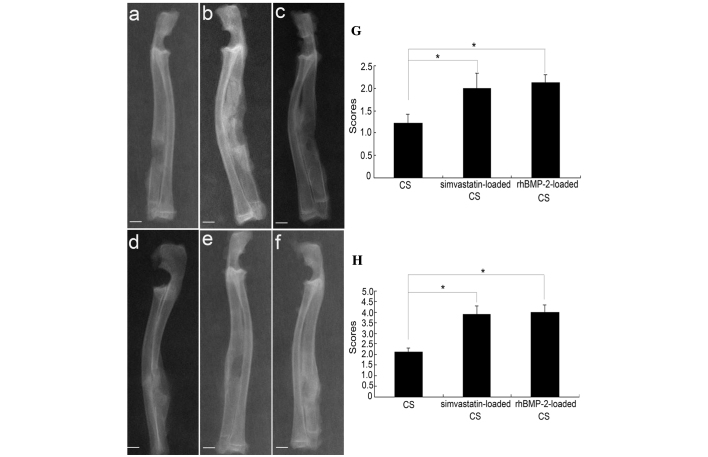
Radiographic analysis of ulnar defects at (A–C) 4 and (D–F) 8 weeks following implantation and Lane-Sandhu X-ray scores (G, 4; H, 8 weeks) in each group. A and D, CS group; B and E, simvastatin-loaded CS group; C and F: rhBMP-2-loaded CS group. Results are expressed as mean ± standard deviation. Scale bar, 5 mm; *P<0.05, vs. CS. CS, calcium sulphate; rhBMP-2, recombinant human bone morphogenetic protein 2.